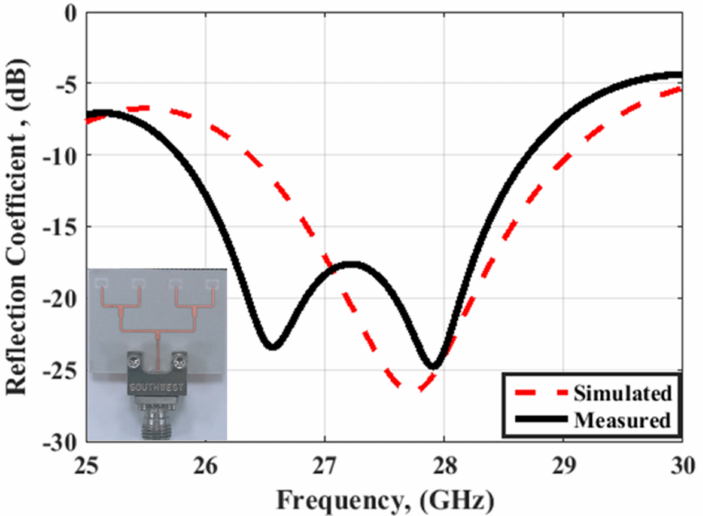
Figure 8. Reflection coefficient simulated and measured results of the 1 × 4 antenna